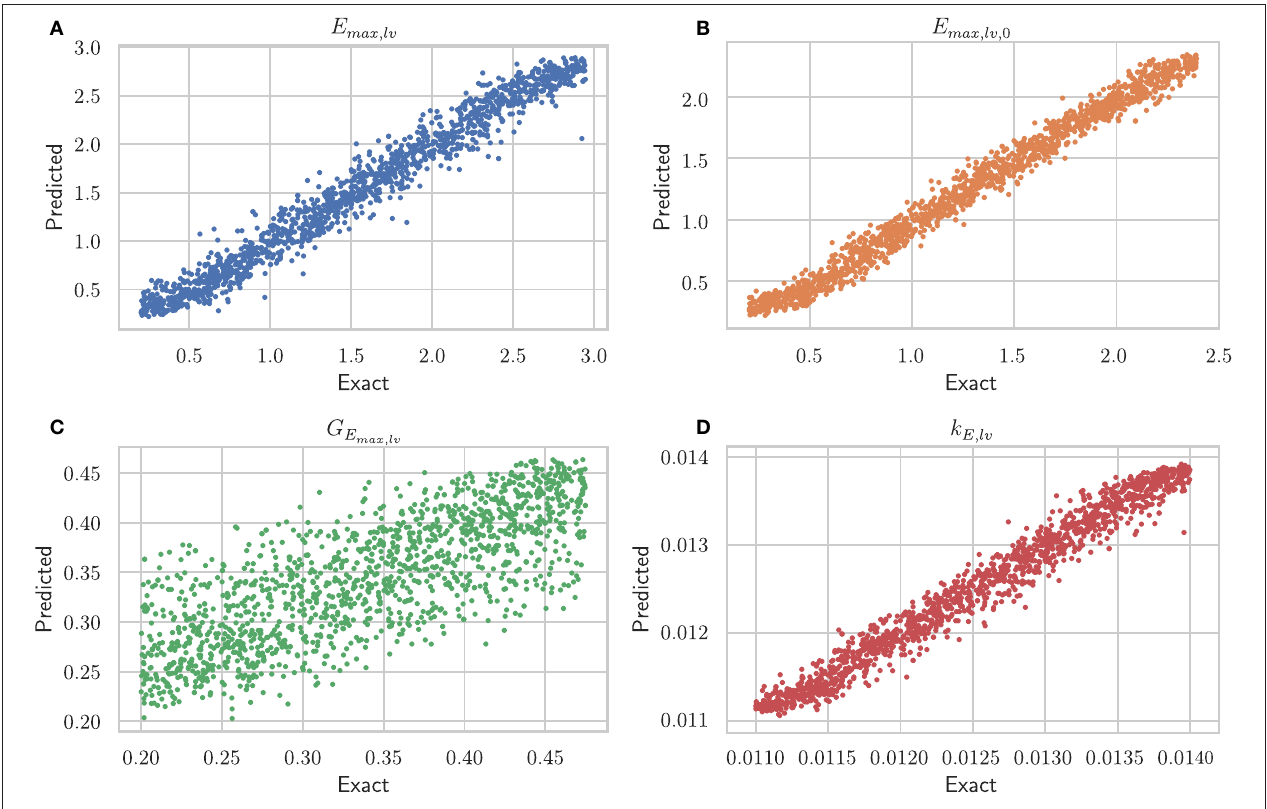
FIGURE 3 | Performance of architecture #2 (see Supplementary Table 2 ) on the test set. For each of the four parameters, the exact value is plotted against the predicted one. (A) E max , lv [mmHg/ml], end-systolic left ventricular elastance; (B) E max , lv ,0 [mmHg/ml], end-systolic left ventricular elastance in absence of baroregulation; (C) G E [mmHg/ml/(spikes/ml)], maximum baroreceptor gain; (D) k E , lv [1/ml], slope of end-diastolic pressure-volume curve. max , lv